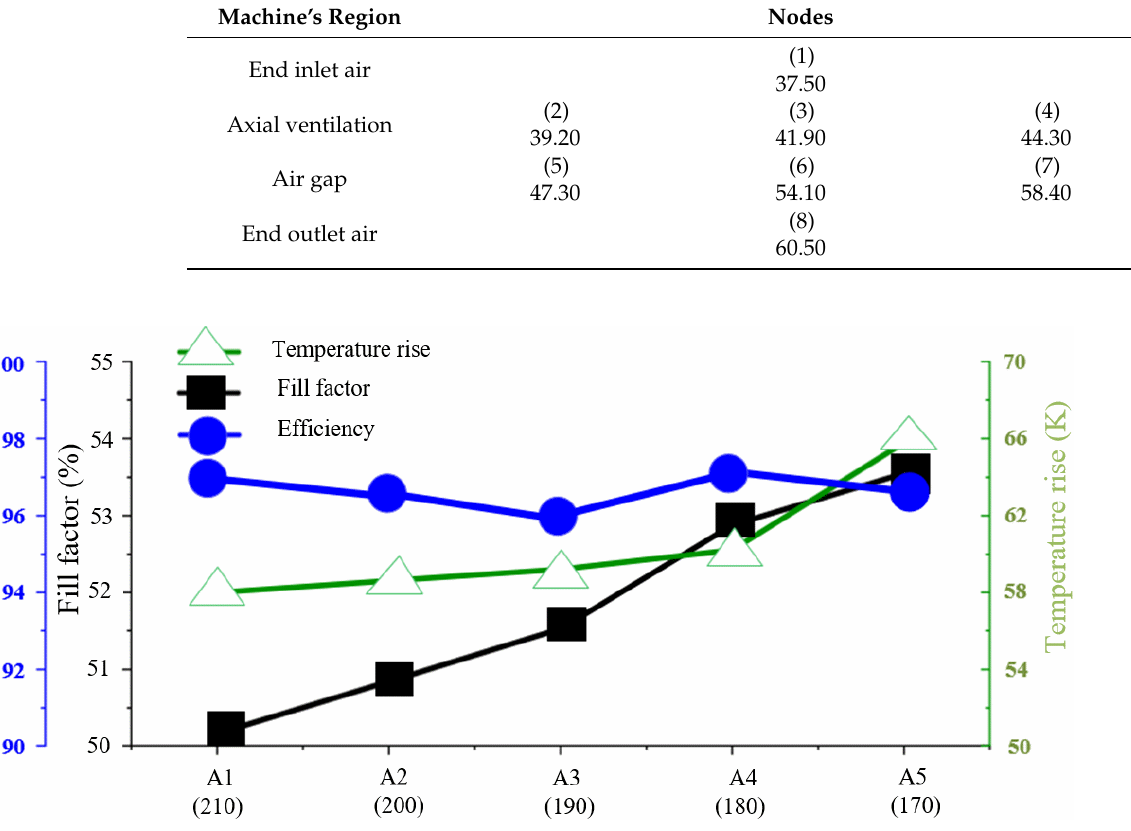
Table 9. An estimated temperature rise of A4 model HSPMSM after sensitivity analysis.